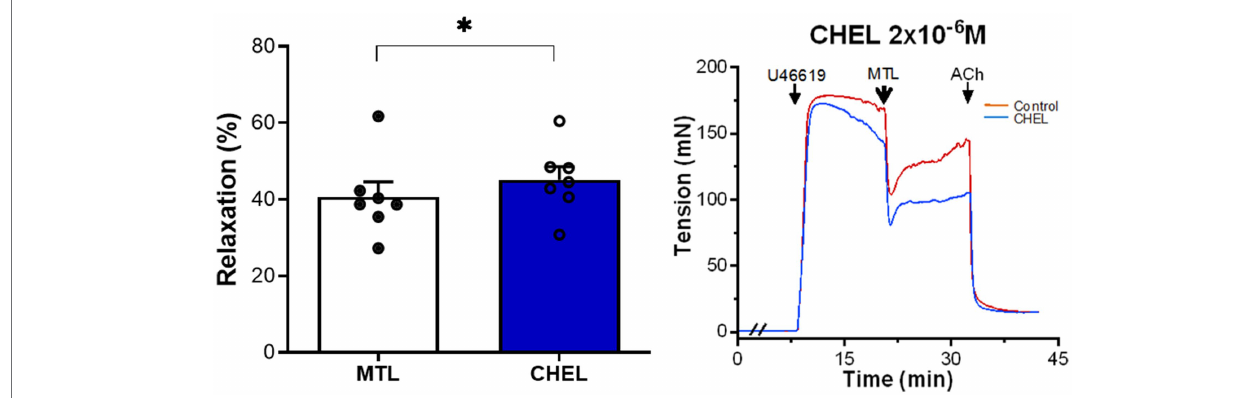
FIGURE 4 | Role of the DG-PKC pathway on motilin-induced vasorelaxation. Effect of chelerythrine (2 × 10 − 6 M) on LGA relaxation induced by motilin (9 × 10 − 8 M) and corresponding representative traces. Values are means ± SEM ( n = 7). * p < 0.05 by paired t -test. The double slash (//) indicates pretreatment with chelerythrine before incubation with U46619. The arrows indicate the time of drug administration. ACh, acetylcholine; CHEL, chelerythrine; DG, diacylglycerol; LGA, left gastric artery; MTL, motilin; PKC, protein kinase C; SEM, standard error of the mean; and U46619, thromboxane A 2 receptor agonist.